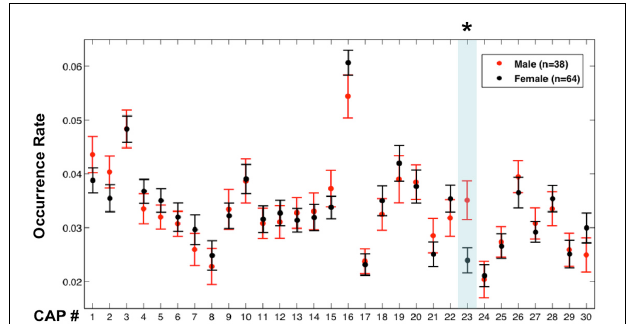
FIGURE 5 | Occurrence rates of the CAPs in males and females. Error bars represent the standard error across participants. The asterisk and light blue shadow indicates CAPs showing a significant difference in their occurrence ( p < 0 . 01 with Bonferroni correction, permutation test) between these two groups.